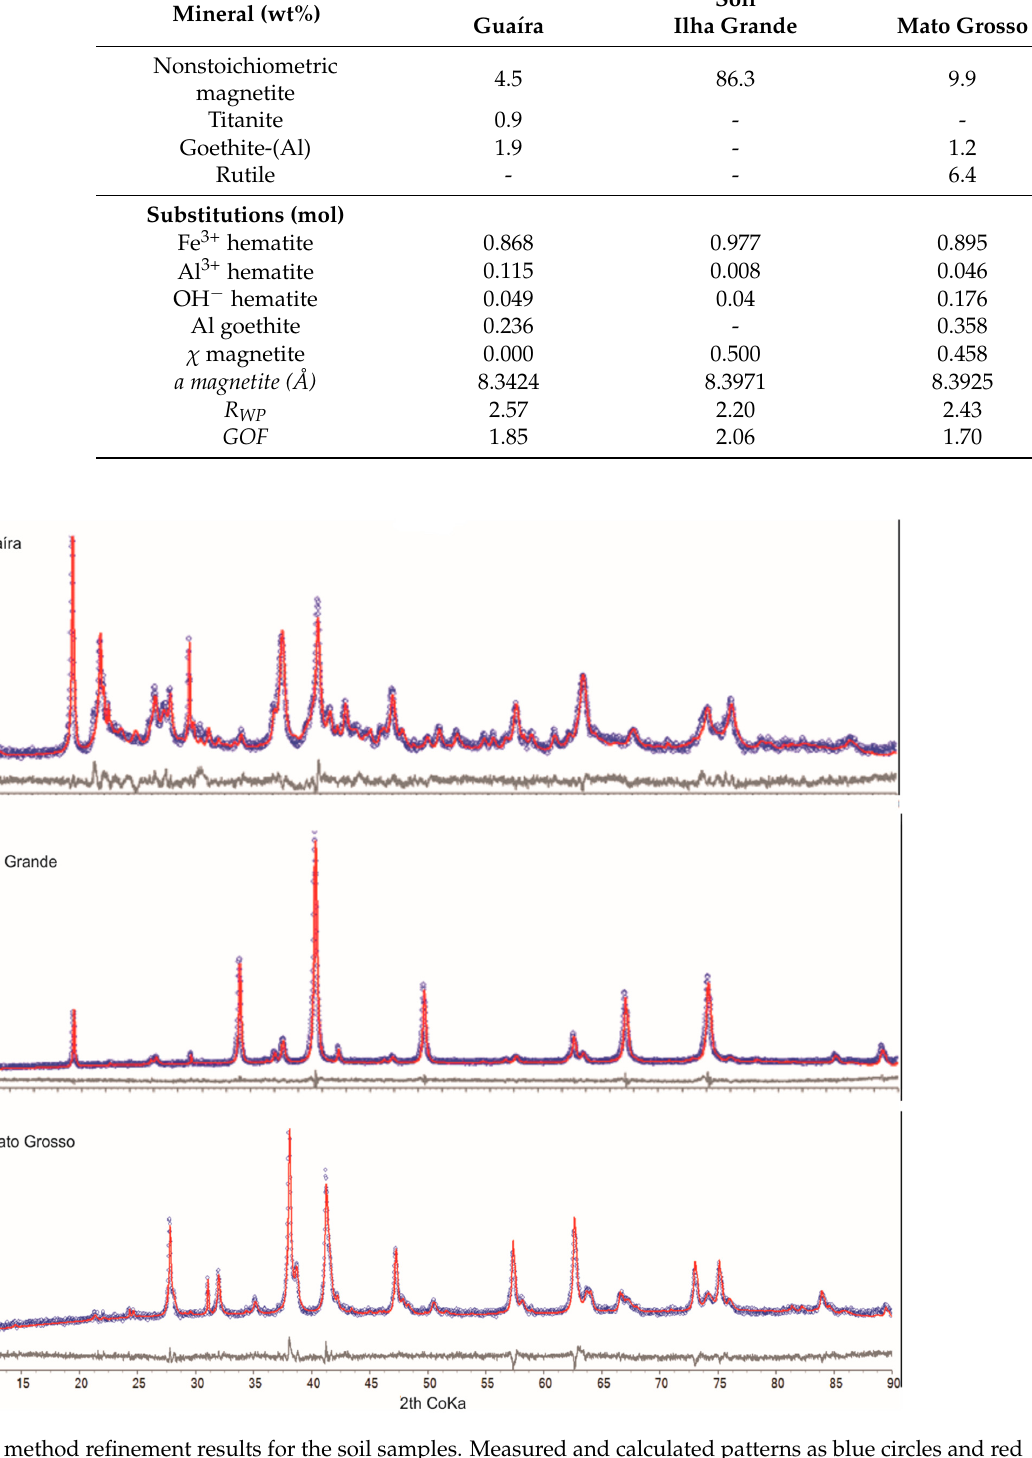
Figure 2. Rietveld method refinement results for the soil samples. Measured and calculated patterns as blue circles and red lines, respectively, residue as the gray line at the bottom.